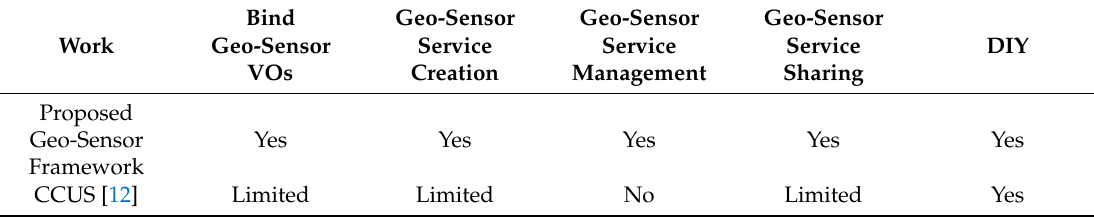
Table 3. Operations and services provision comparison from user-level.